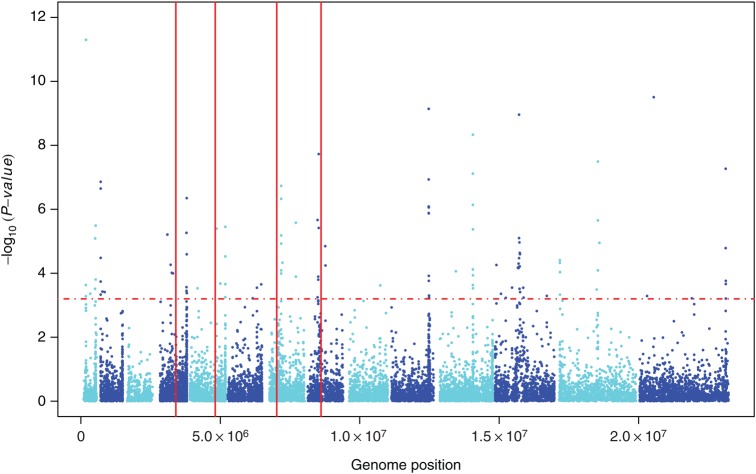
Positive directional selection in the Malawian Plasmodium falciparum population. Dashed line indicates genome-wide integrated haplotype scores at a significance threshold of P < .0006. Vertical lines indicate (from left) locations of pfdhfr, pfmdr1, pfcrt, and pfdhps, respectively.